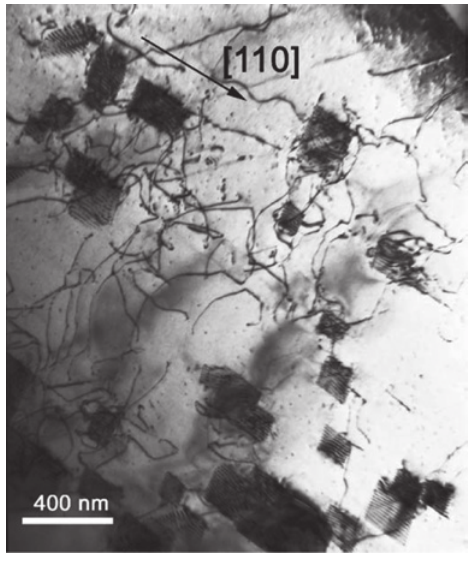
Fig. 6: TEM bright field image, HP-NbTi alloy, showing details of the secondary chromium carbide precipitation. The [110] carbide /[110] γ orientation relationship is illustrated